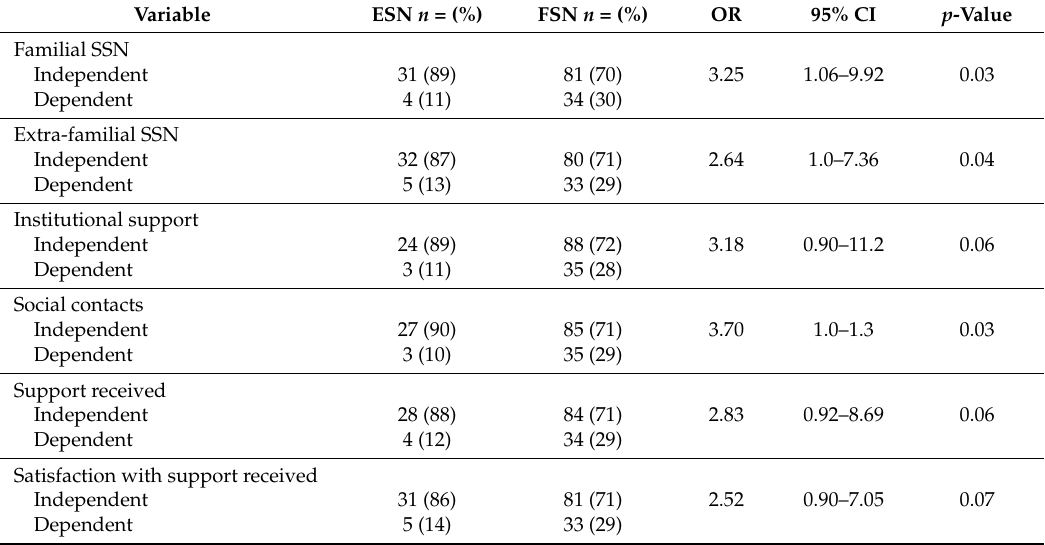
Table 2. Social support networks as a risk factor for activities of daily living (ADL) dependence.